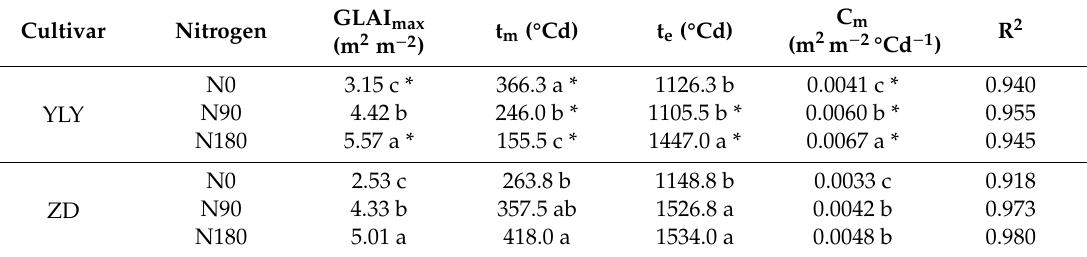
Figure 3. Green leaf area index (GLAI) of YLY ( A , C ) and ZD ( B , D ) as a function of thermal time under di ff erent N treatments in 2016 ( A , B ) and 2017 ( C , D ). Vertical bars represents S.D. of the mean ( n = 3) where these exceed the size of the symbol. Table 2. Estimated values for the growth of green leaf area for YLY and ZD in 2016.